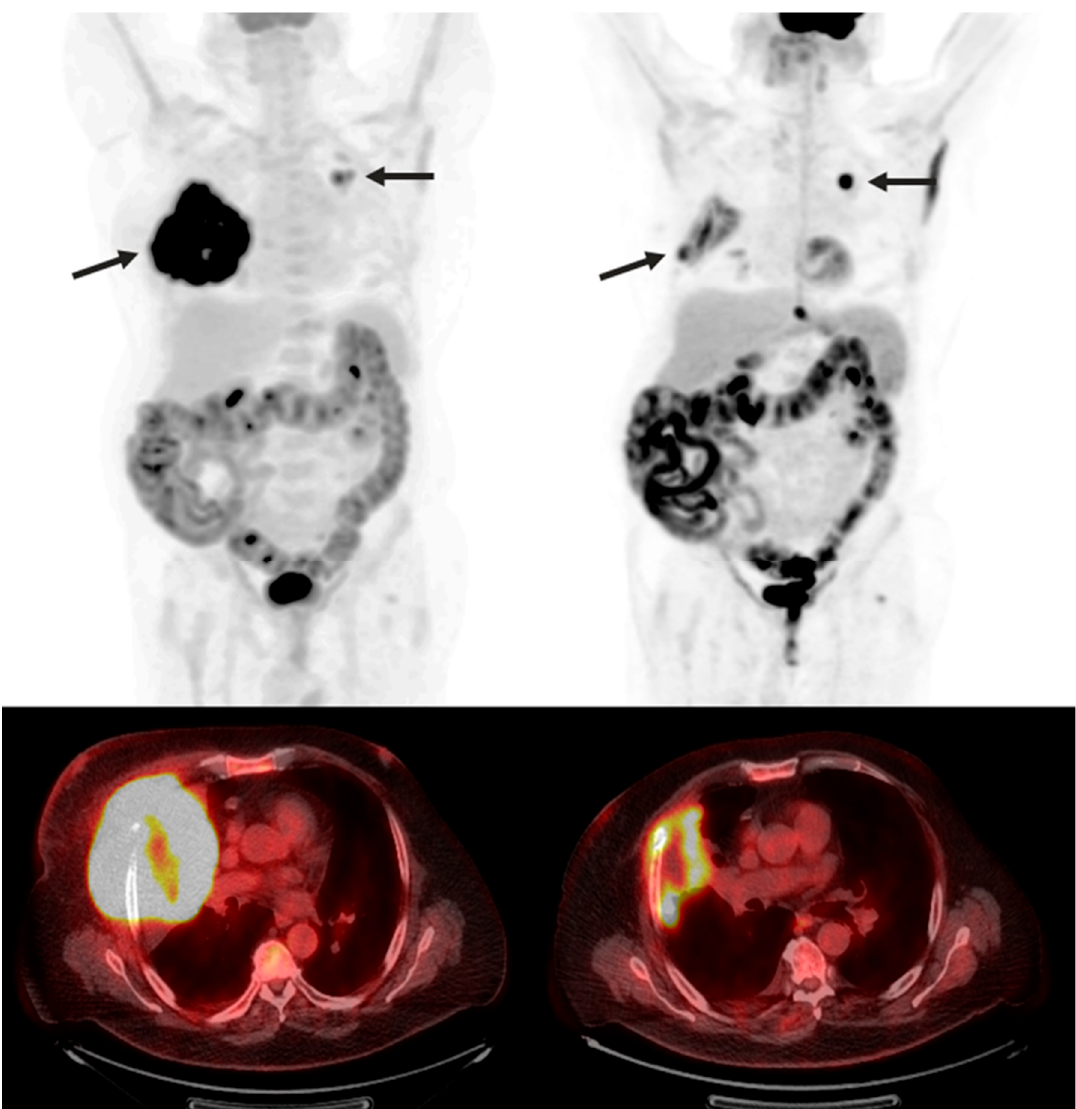
Figure 4. A 70-year-old man with refractory diffuse large B-cell lymphoma. Maximum intensity projection and axial fused FDG PET/CT pre- (right) and 3 months post- (left) CAR T-cell therapy showing marked decrease in size and FDG uptake of right upper lobe lymphomatous mass invading the right chest wall (arrow). Slight increase in FDG uptake of left upper lobe pulmonary nodule (arrow), also suspicious for lymphoma.